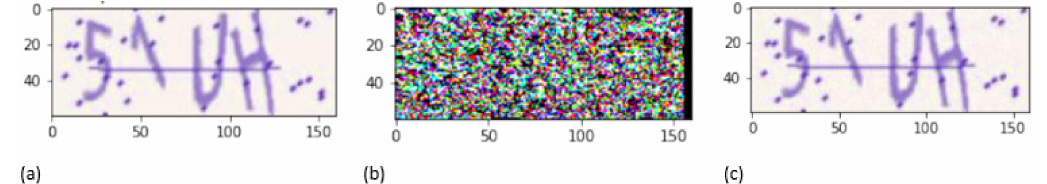
Figure 3. ( a ) Sample conventional text-based CAPTCHA generated; ( b ) sample adversarial or vector noise to be injected into the conventional text-based CAPTCHA; ( c ) sample of the generated adversarial text-based